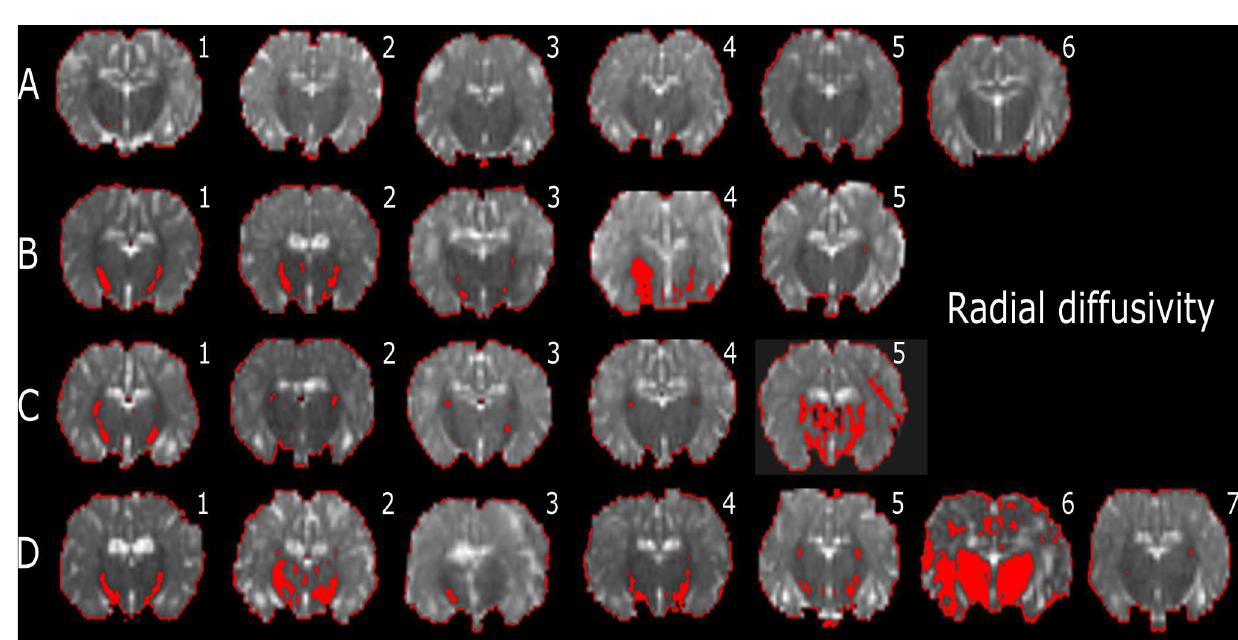
Fig 5. Representative slices of whole-brain DTI colour maps of the thalamus (Th) for radial diffusivity (RD). Voxel diffusivity intensities falling belowthe low threshold are shown in red for RD measurements for all lamb brains. All low-diffusion maps are overlaidon diffusion images for a slice passingthrough the Th. All lambs in the unoperatedcontrol (Cont n = 6; A) group had no low RD values in the Th, but low RD values appearedin the Th of 4 lambs followingsham surgery (Sham n = 5; B), 4 lambs followinginjuriousventilation(INJ n = 5; C), and 6 lambs followingumbilicalcord occlusion (INJ+UCO n = 7; D).